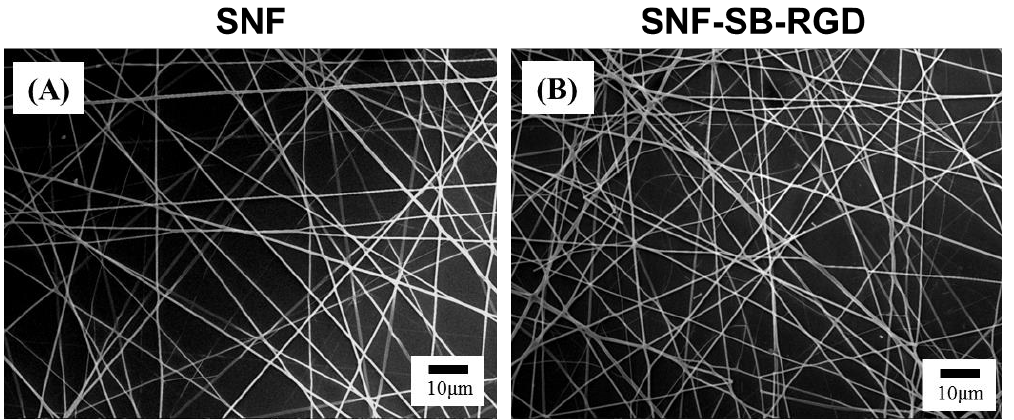
Figure 4. SEM images of ( A ) SNF and ( B ) SNF-SB-RGD. The scale bar represents 10 μm.